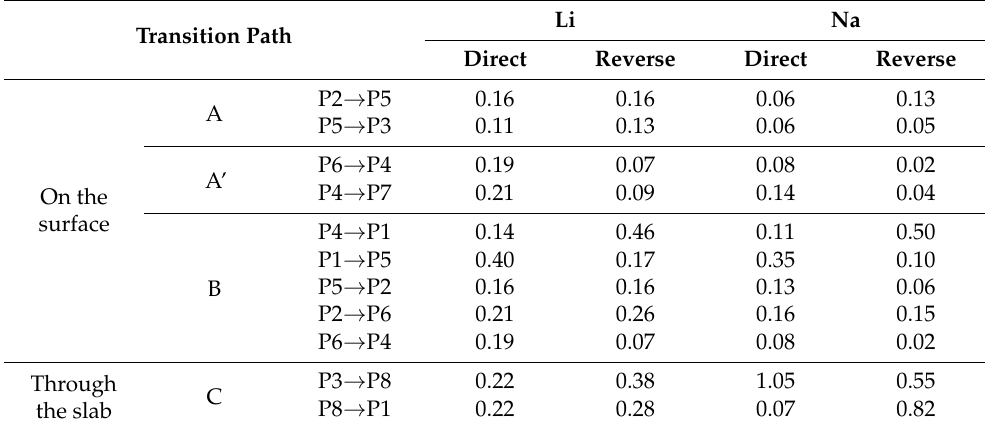
Table 2. The energy-barrier values for the diffusion of alkali-metal atom (Li or Na) on the surface of the A’-MoS 2 monolayer and through the pore. Li Na Transition Path Direct Reverse Direct